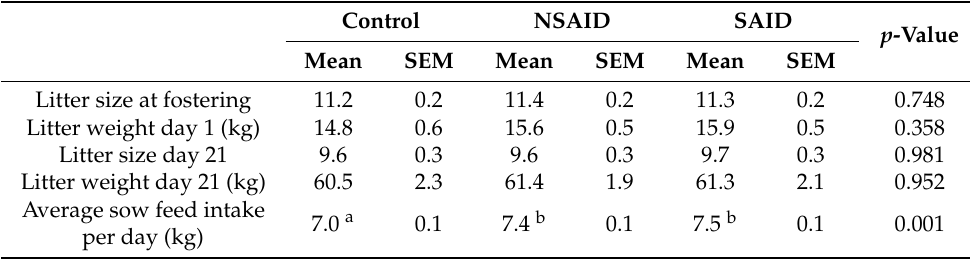
Table 3. The effect of saline (Control), a non-steroidal anti-inflammatory (NSAID), or steroidal anti- inflammatory (SAID) administration prior to farrowing on litter size, litter and average piglet weight measured on day one and day 21, and average lactation feed intake (mean ± SEM). a,b represents a significant difference ( p < 0.05) within